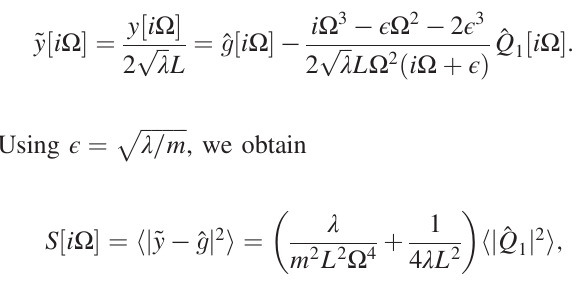
FIG. 10. Michelson ’ s interferometer with type-2 CF. The CF controller is an optical cavity with coupling constant ϵ and detuning α . HWP denotes a half-wave